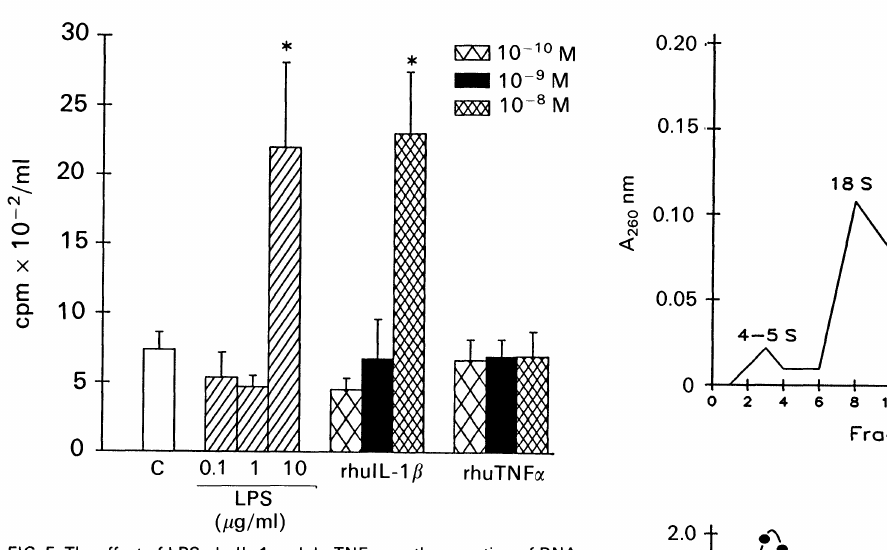
FIG. 5. The effect of LPS, rhulL-1 and rhuTNF- on the secretion of RNA by resident macrophages. Macrophage monolayers were preincubated with [5-3H]-uridine (5 #Ci/ml) for 2 h. This specific precursor of RNA synthesis was then removed from the cultures and the cells were incubated with LPS or recombinant human cytokines (rhulL-1 and rhuTNF-) for 6 h. The supernatants were treated with TCA and processed for 3H-RNA detection as described in Materials and Methods. The results (counts per minute; cpm) are expressed as the mean -t- S.E.M. of experiments performed in quadruplicate. *p < 0.05 compared with control value (ANOVA; Duncan’s test).